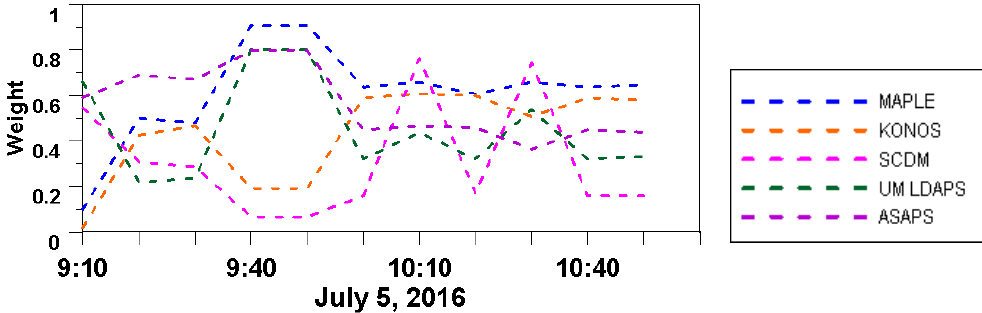
Figure 8. Time series of the weights of all models estimated from the HS method for Case 3.